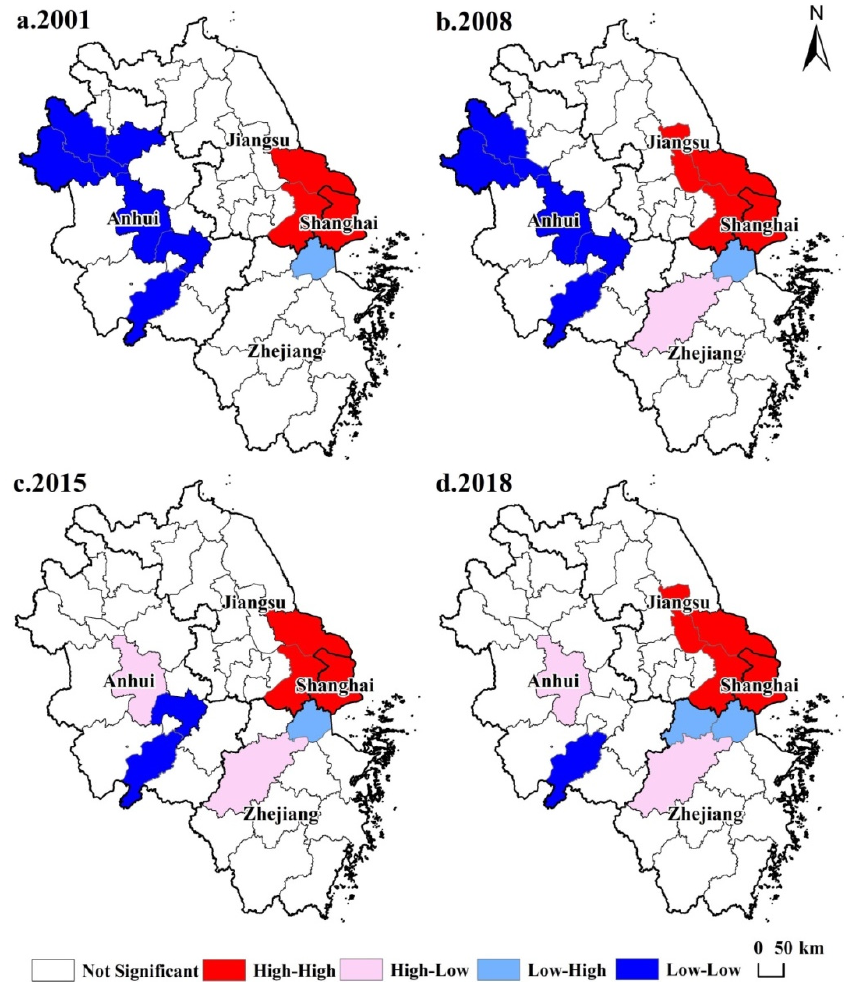
Figure 6. Map of LISA agglomeration of startups in the Yangtze River Delta ( a ) in 2001, ( b ) in 2008, ( c ) in 2015, and ( d ) in 2018.